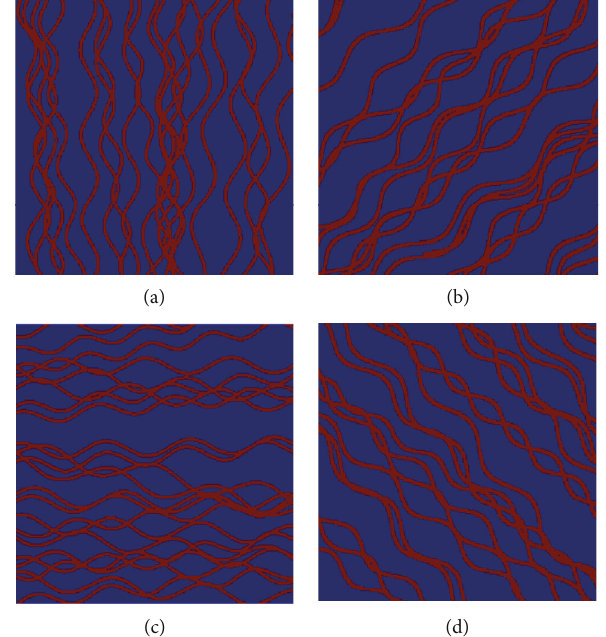
Figure 4: Training images (TIs) with di ff erent channel directions: (a) 0 degrees (TI 1), (b) 45 degrees (TI 2), (c) 90 degrees (TI 3), and (d) 135 degrees (TI 4)